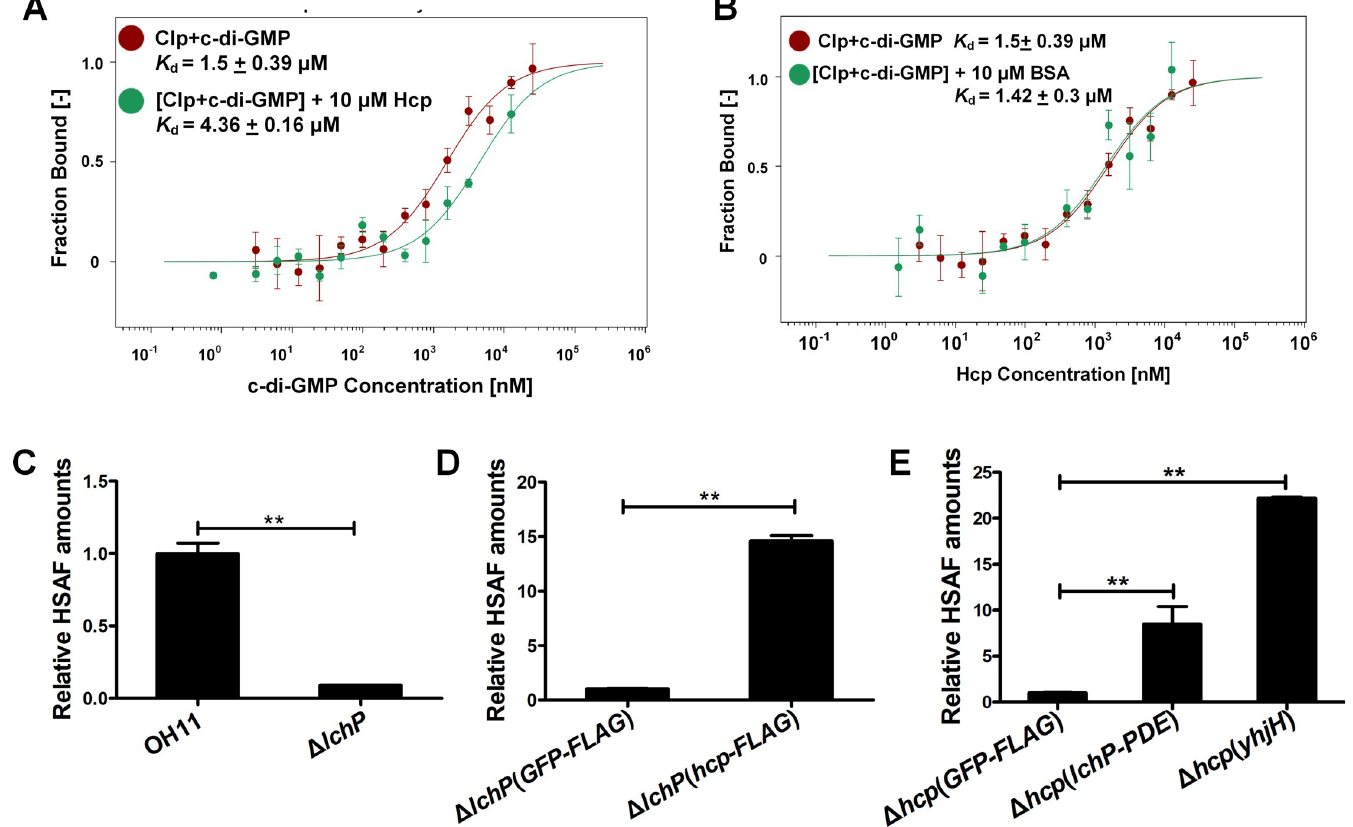
Fig 4. Hcp protects Clp from c-di-GMP binding, which increases HSAF production. (A-B) MST experiments. Fluorescently labeled proteins (10 μ M) were titrated against increasing concentrations of c-di-GMP. GST-Clp—c-di-GMP binding in the absence ( K d , 1.50 μ M; red trace) or presence of 10 μ M Hcp-His 6 ( K d , 4.36 μ M; green trace) (A) . Lack of the effect of 10 μ M BSA on GST-Clp—c-di-GMP binding ( K d , 1.42 μ M; green trace), and lack of Hcp-His 6 —c-di-GMP binding (No-binding; blue trace) (B) . (C-D) Relative HSAF amounts in the strains OH11 and Δ lchP grown in 1/10 TSB without gentamycin (C) , and strains containing the plasmids GFP-FLAG and Hcp-FLAG grown with gentamycin (D) . (E) HSAF production in the Δ hcp mutant in the presence of c-di-GMP PDEs. LchP-PDE, a cytoplasmic fragment (PAS+GGDEF+EAL domains) of the L . enzymogenes LchP; YhjH (PdeH), E . coli PDE.